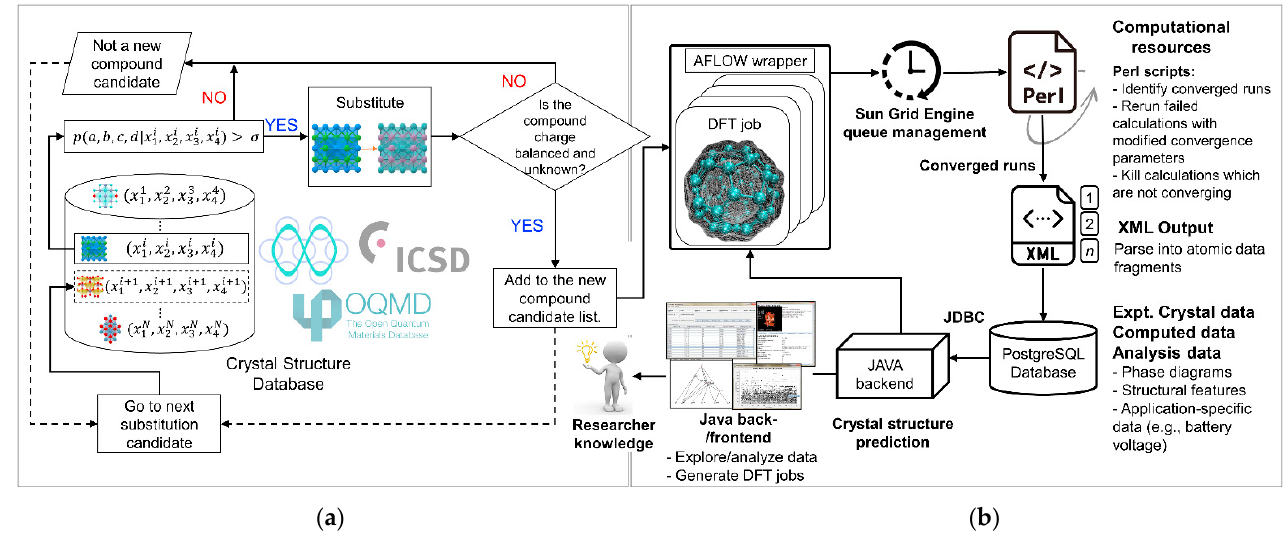
Figure 7. Schematic diagram of Ceder et al. combined data mining and high-throughput ab initio computing methodology for novel cathode materials development: ( a ) substitutional probabilistic model to predict new compounds formed by a, b, c, and d species (Adapted with permission from Ref. [93]. Copyright 2011, American Chemical Society); ( b ) data flow implementation in their high-throughput project (Adapted with permission from [102]. Copyright 2011, Elsevier).